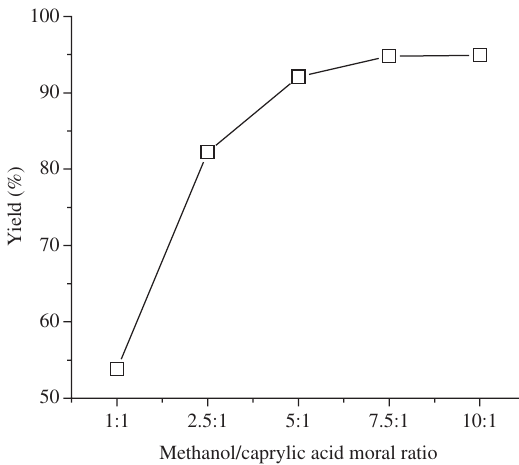
Figure 3 Yield of methyl caprylate by esterification of caprylic acid with methanol over (Tshx)(HSO acid molar